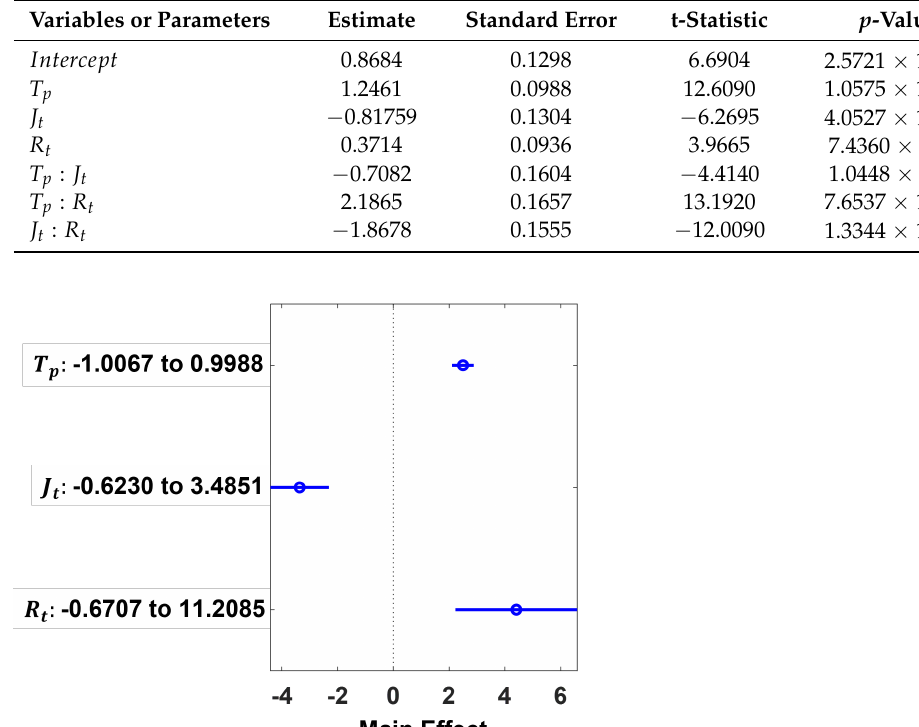
Table 11. Summary of estimated coefficients and statistics for the regression analysis.